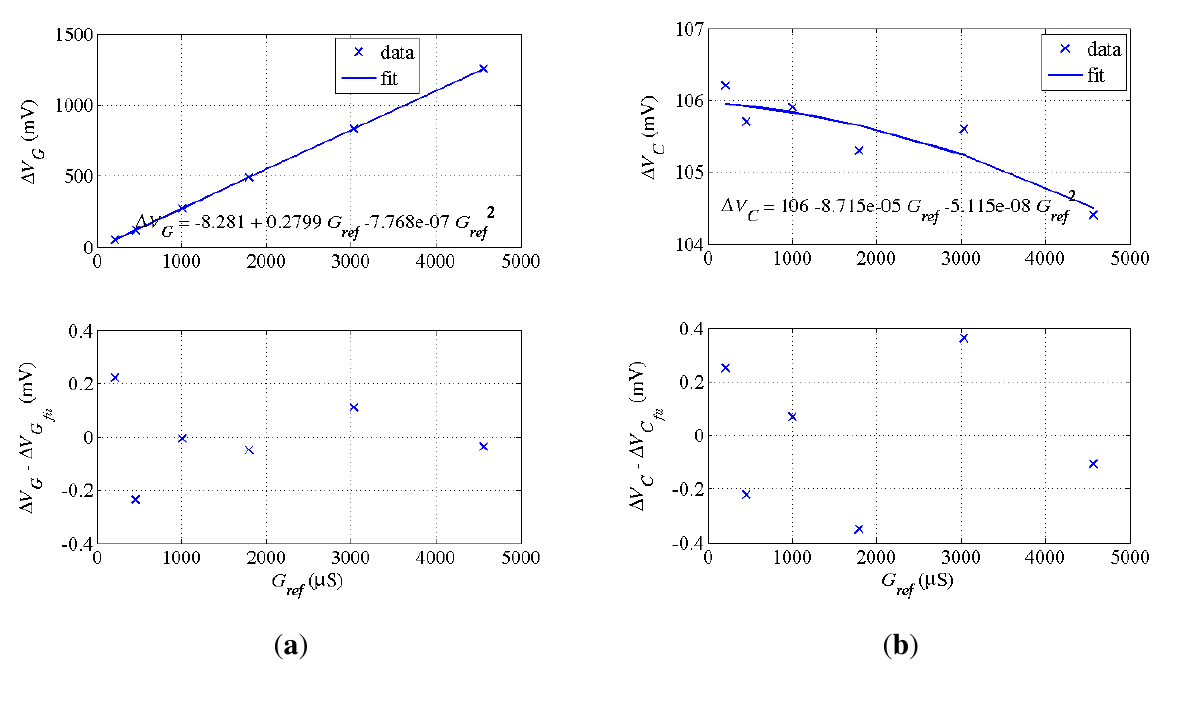
Figure 7. Sensor output ∆ V ( a ) and ∆ V ( b ) as a function of the reference G G C using calibration data and Equation (18). For each voltage, the difference in mV between data and its fit from Equation (18) are also plotted. Channel parameters are deduced from the ( G ) and difference with fit. Hence, G = − 3 . 57 µ S · mV − 1 . r fits. ( a ) Plot ∆ V G ref eq ( G ) and difference with fit. Hence, ϕ = 0 . 31 10 − 3 ( b ) Plot ∆ V C ref G/C